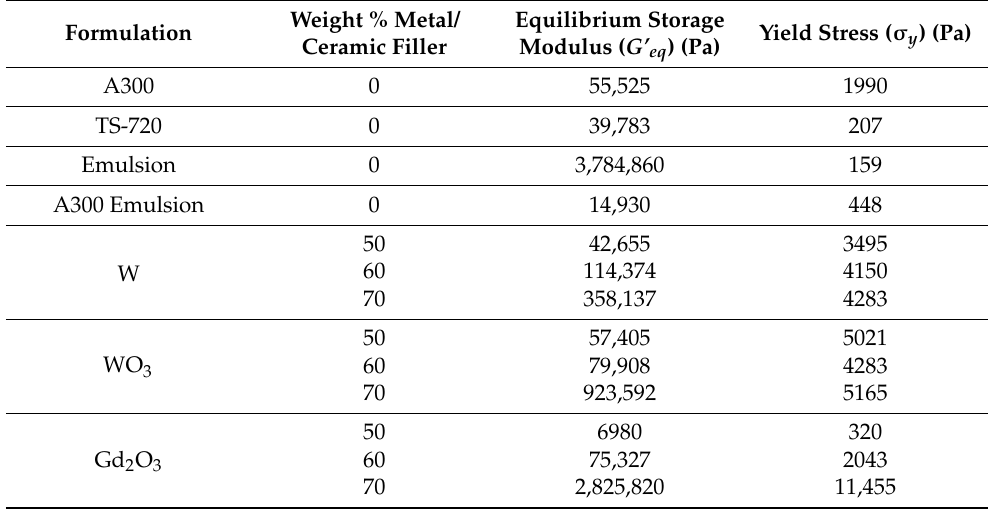
Figure 1. Rheological analyses results showing the storage modulus as a function of oscillation stress for representative samples of the DIW inks created in this study. Table 3. Rheological properties of a representative sample of each ink formulation created in this study.